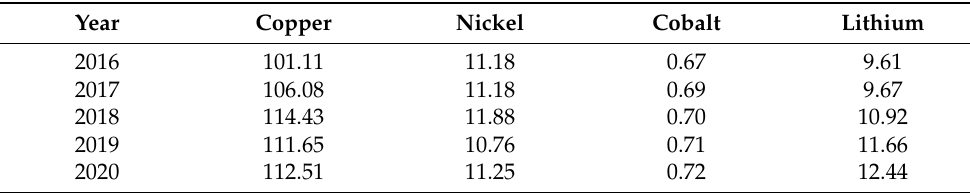
Table 10. Proven resource reserves of China’s mineral resources in 2016–2020 (Unit: MT) (Data Source: